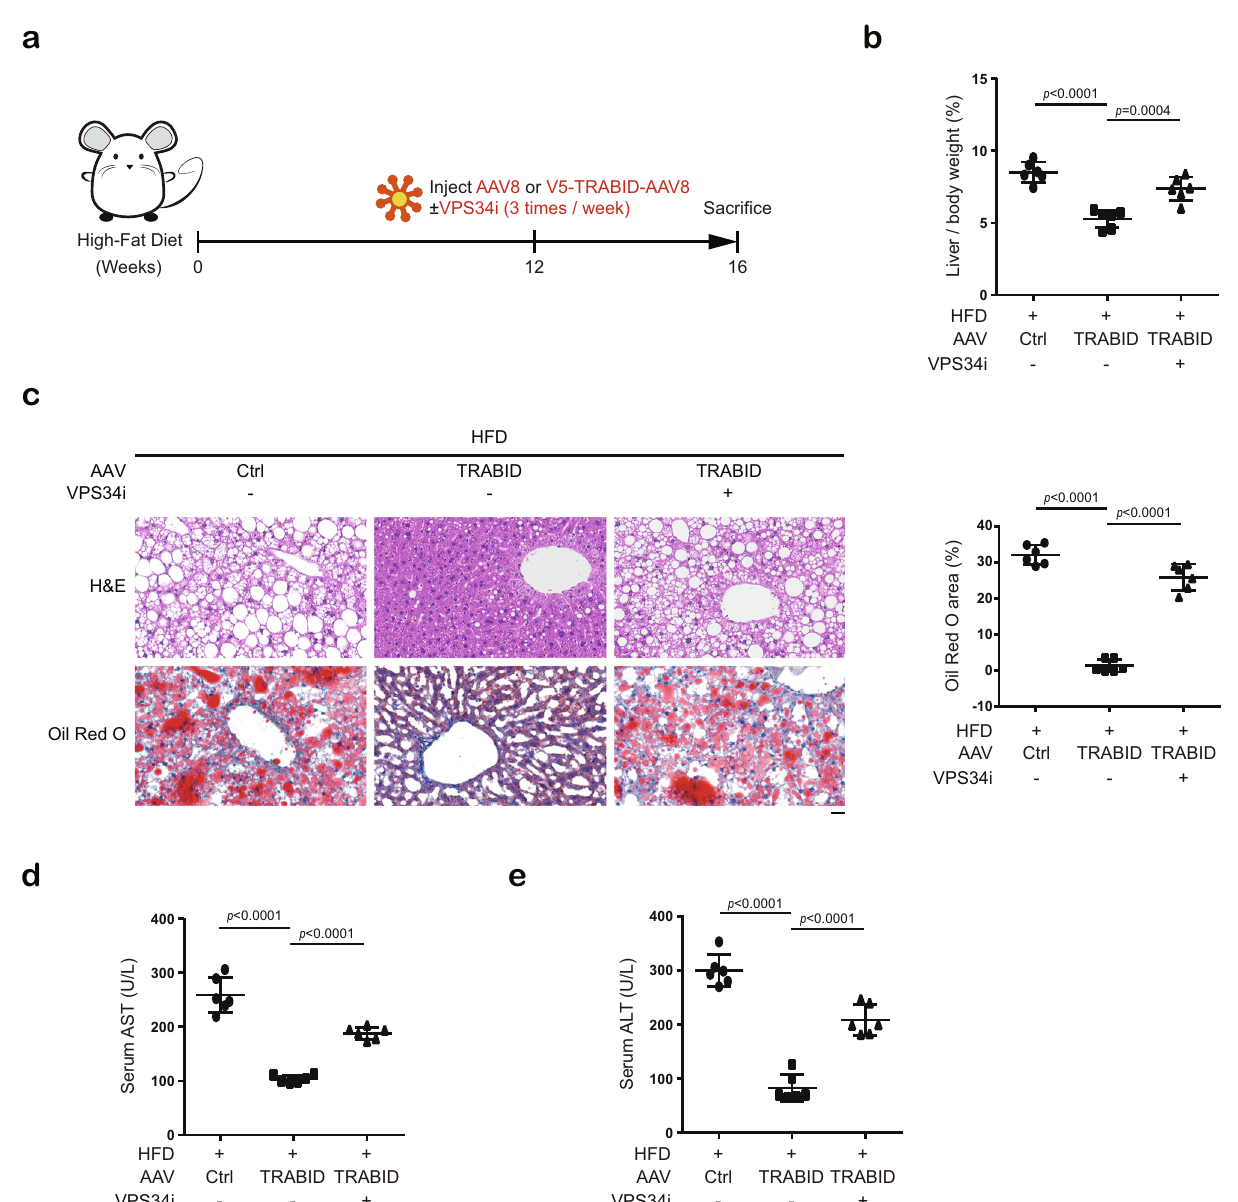
Fig. 8 VPS34 inhibitor reverses the NAFLD protective effects of TRABID. a Schematic representation of the experimental design to evaluate whether the NAFLD protective effects of TRABID is mediated by VPS34. b The percentage of liver per body weight in indicated mice. Data are mean ± SD from six mice. P -values are determined by one-way ANOVA with Tukey ’ s post hoc test. c H&E and Oil Red O staining of liver sections taken from indicated mice. Bar, 50 μ m. The percentages of area stained positive for Oil Red O were quanti fi ed and shown on the right. Data are mean ± SD from six mice. P -values are determined by one-way ANOVA with Tukey ’ s post hoc test. d , e AST and ALT assays in indicated mice. Data are mean ± SD from six mice. P -values are determined by one-way ANOVA with Tukey ’ s post hoc test. Source data are provided as a Source Data fi Flag-VPS34 together with other constructs were lysed with RIPA lysis buffer. Lysates were subjected to immunoprecipitation with anti-Flag M2 beads, followed by western blot analysis. In all experiments, the equal expression of His-ubiquitin or its variants was checked by western blot.